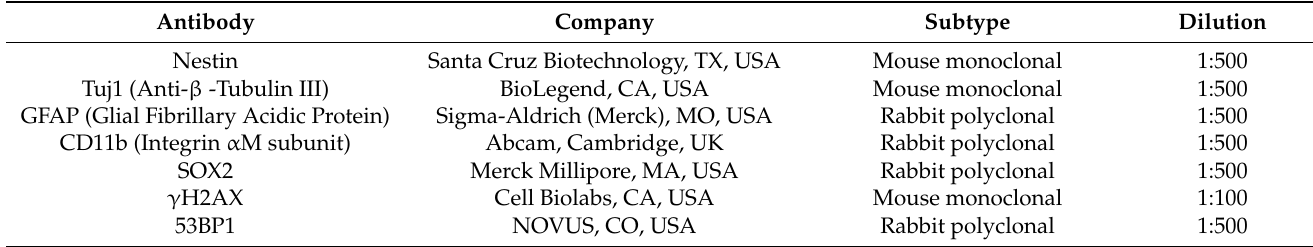
Table 1. List of primary antibodies used for immunofluorescent staining.